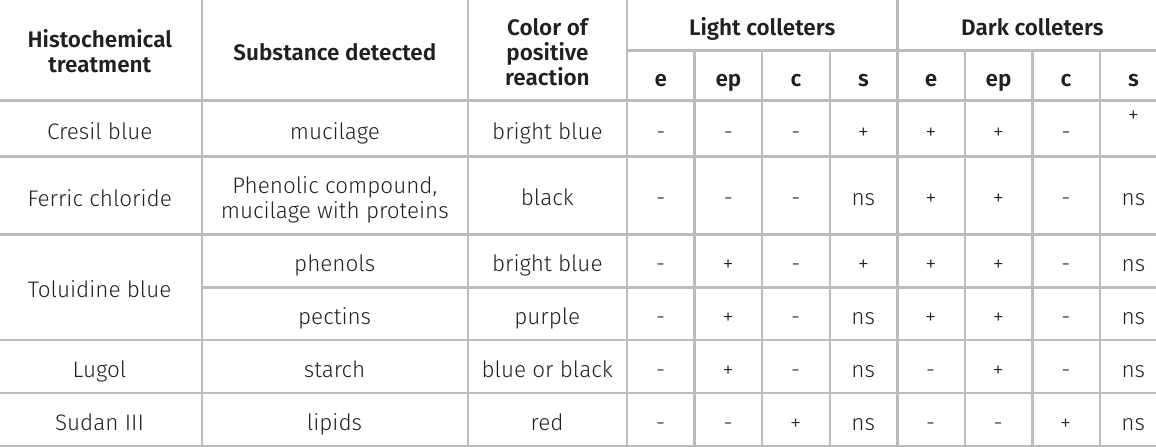
Table III. Histochemical tests performed on colleters of C. glabratus . Histochemical